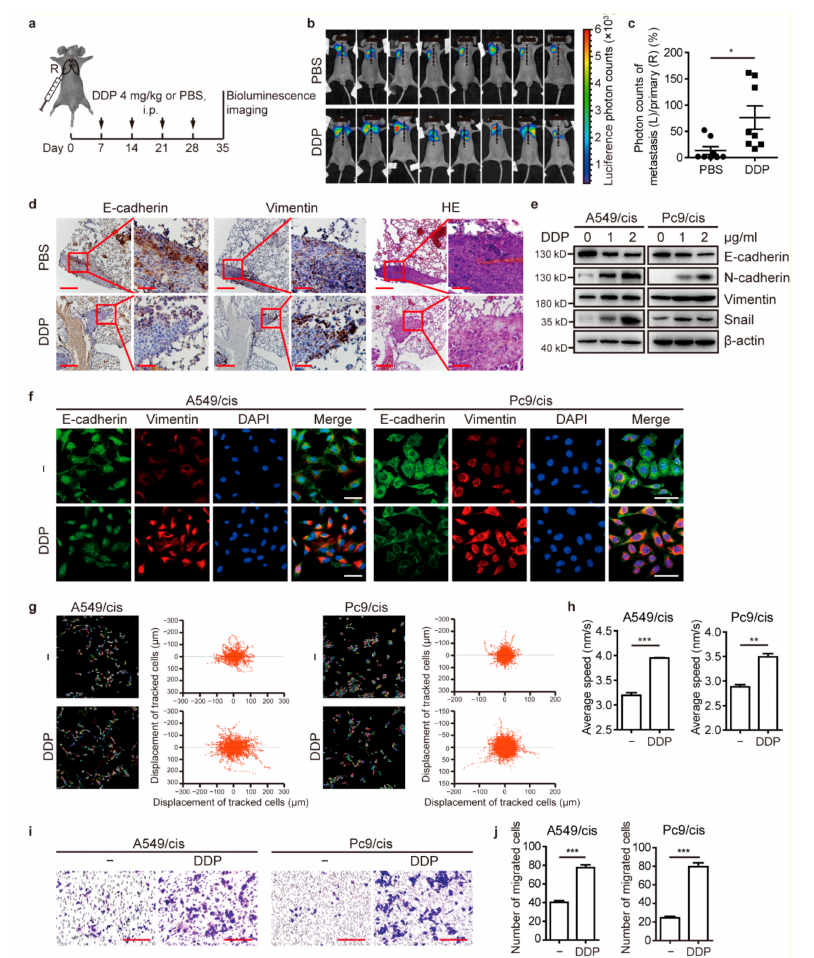
Figure 1. Cisplatin promotes EMT and tumor metastasis in chemotherapy-resistant LUAD. ( a ) Ex- perimental design and chemotherapy administration. Pc9/cis-luciferase cells were inoculated into the right lung of BALB/c nude mice ( n = 8 per group) to establish an orthotopic tumor xenograft model. On day 7, mice were intraperitoneally injected with 4.0 mg/kg cisplatin or an equivalent volume of PBS every 7 days. Thirty-five days after tumor cell inoculation, mice underwent a bio- luminescence test and were sacrificed. The primary tumors in the right lung and metastatic foci in the left lung were subjected to IHC staining. ( b , c ) Bioluminescence imaging ( b ) and quantitation ( c ) from mice with orthotopic tumor xenografts. ( d ) Representative IHC staining images of E-cadherin and Vimentin expression in paraffin-embedded serial sections of the primary lesion (right lung) from orthotopically implanted mice from Figure 1a. Scale bar: 200 µ m (left) and 50 µ m (right). ( e ) Western blot analysis of EMT proteins. Cells were cultured with or without cisplatin for 24 h. ( f ) Representative IF images of EMT markers and DAPI in cells treated with 2 µ g/mL cisplatin or vehicle control for 24 h. Scale bar: 50 µ m. ( g , h ) Dynamic imaging analyses of cell migration. Cells were pretreated with 2 µ g/mL cisplatin or vehicle control for 24 h. Cell migration was tracked over 16 h by HCS. Representative images of the single-cell motion track (left panel) and single-cell ultimate displacement (right panel) are shown in ( g ). The average speed was measured in ( h ). ( i , j ) Transwell assay confirming the effect of cisplatin on cell migration. Images of the cells on the underside of the membrane are shown in ( i ) after culture for 6 h in the presence of a chemoattractant. Scale bar: 200 µ m. Quantification of migrated cells is depicted in ( j ). * p < 0.05, ** p < 0.01, *** p < 0.001, t -test. DDP, refers to cis-diamminedichloridoplatinum (II), also known as cisplatin or